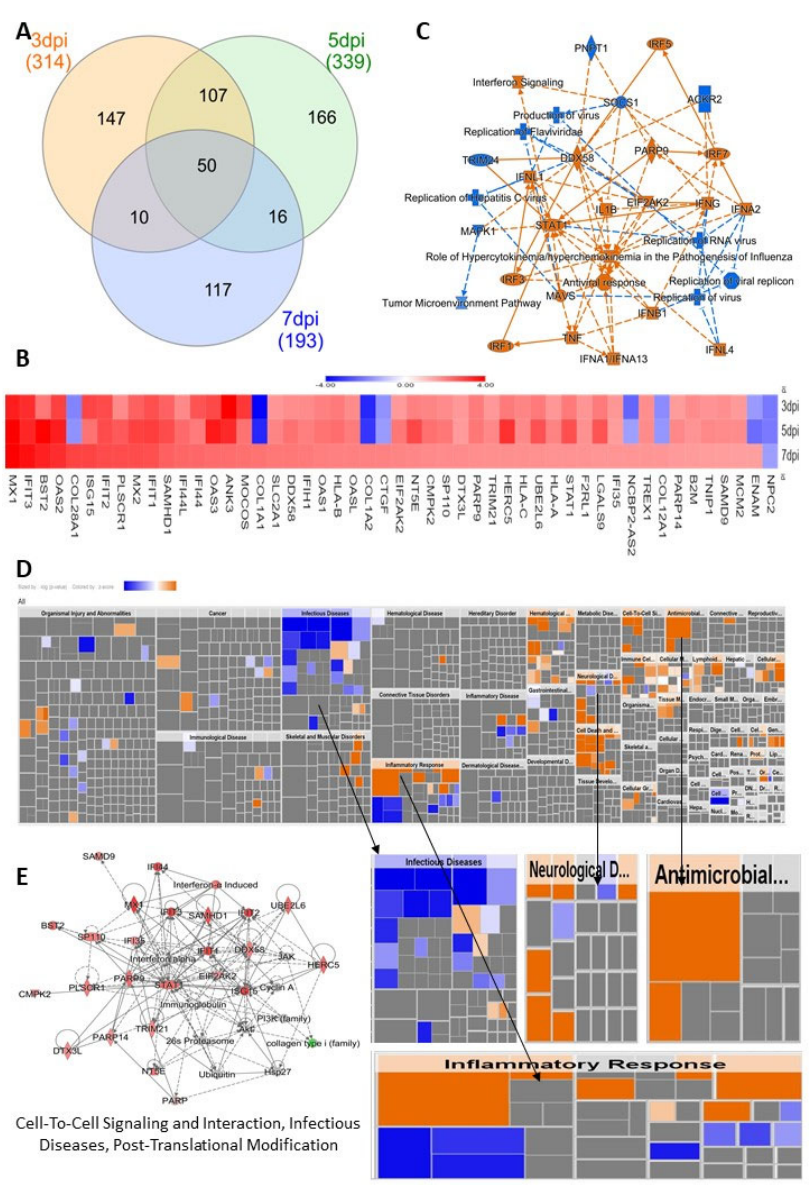
Figure 4. Impact of commonly affected proteins in HSerC by ZIKV on cellular functions and diseases. ( A ) Venn diagram of altered proteins at 3, 5 and 7 dpi. ( B ) Summary of IPA analysis showing the most affected bio-functions, canonical pathways and affected protein networks and their relationship by the commonly affected proteins. ( C ) Heatmap of the 50 commonly affected proteins at 3, 5 and 7 dpi. Red/orange and blue represent up ‐ regulation and down ‐ regulation, respectively. ( D ) Heat map of the disease and biofunctions affected by the commonly affected proteins. ( E ) The protein–protein interaction networks affected by the commonly altered proteins. Red and green represent up ‐ regulation and down ‐ regulation, respectively; gray proteins denote that they were recognized in the present study, but not significantly regulated; colorless proteins interact with molecules in the network, but were not identified in our study. Abbreviations. dpi = Days post infection.